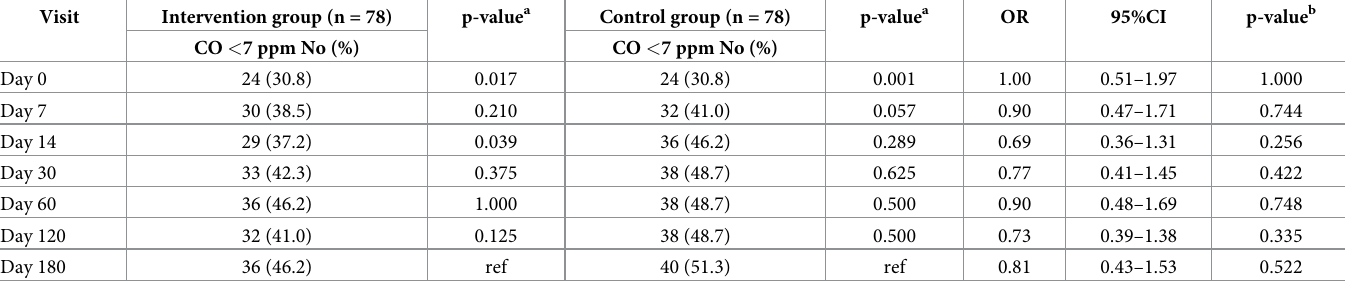
Table 5. Comparisons of carbon monoxide (CO) levels between the intervention and control groups on days 0, 7, 14, 30, 60, 120, and